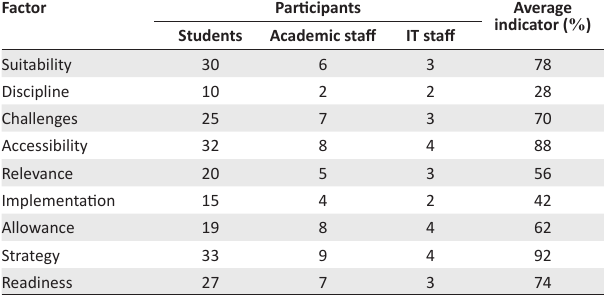
TABLE 2: Bring your own device parameters by sample population.